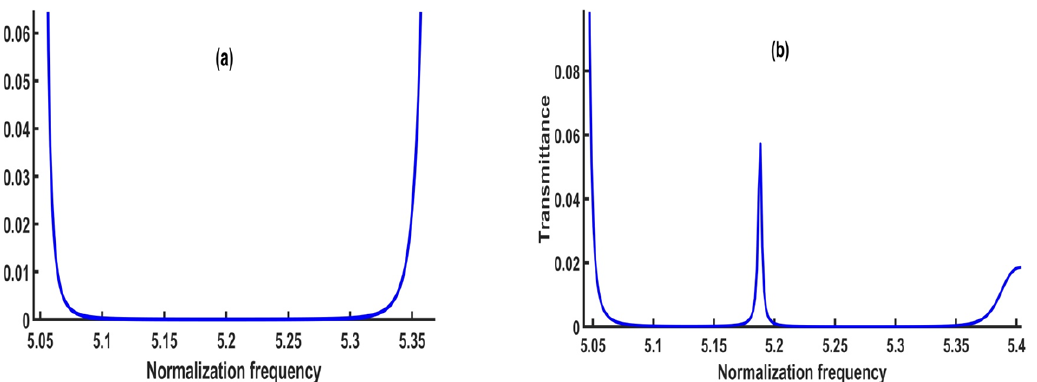
Figure 3. The transmission spectrum of ( a ) the perfect 1D PnC structure and ( b ) the 1D defective PnC structure.